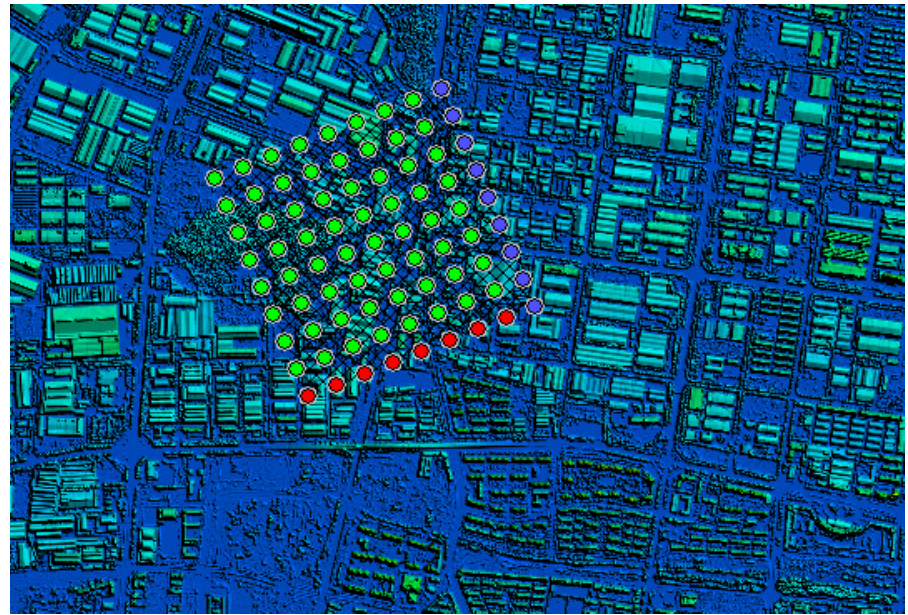
Figure 5. An example of 8 × 8 grids on the city’s DSM–DEM (each grid is 100 × 100 m).